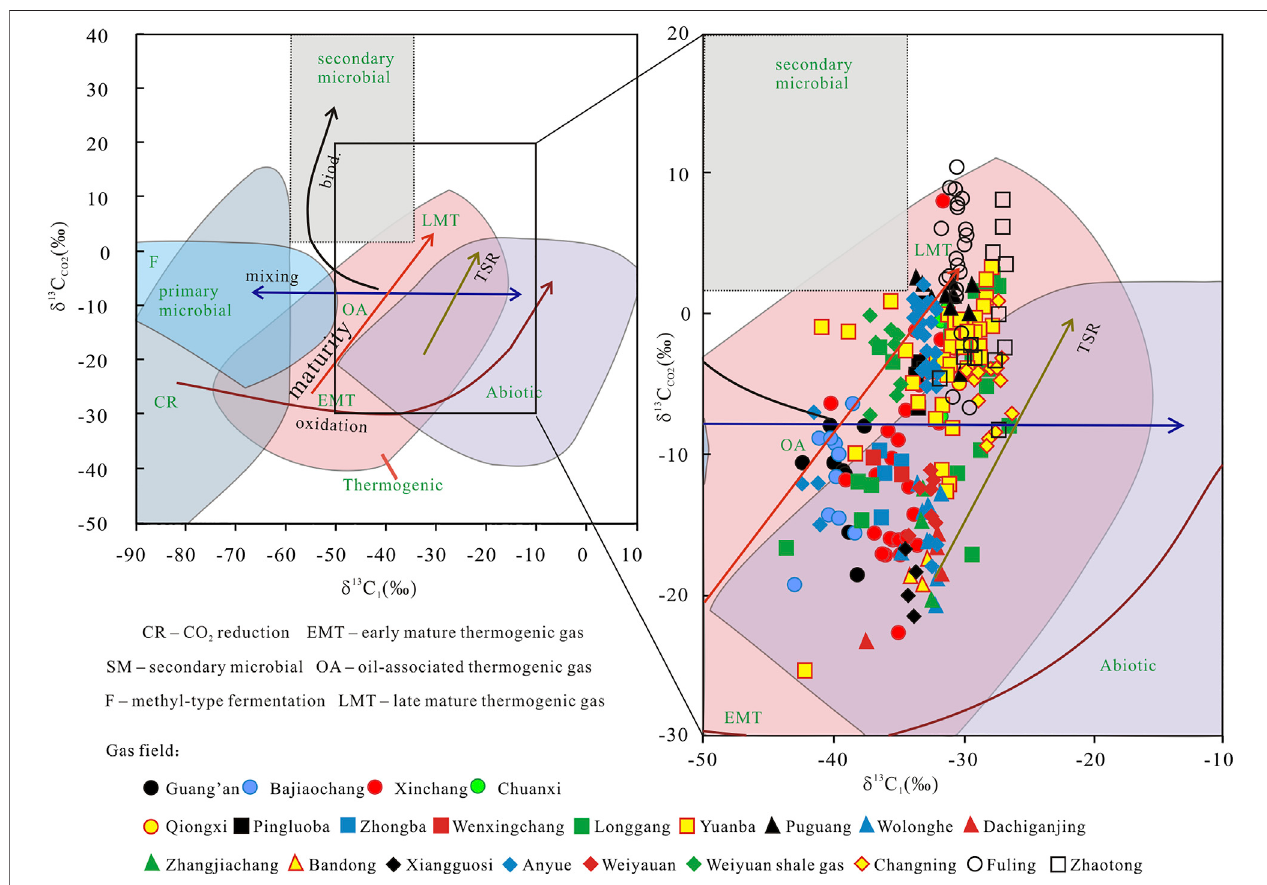
FIGURE 7 | Plot of δ 13 C 1 − δ 13 C CO2 of natural gases from gas fi elds in the Sichuan Basin (Modi fi ed after Milkov and Etiope, 2018).